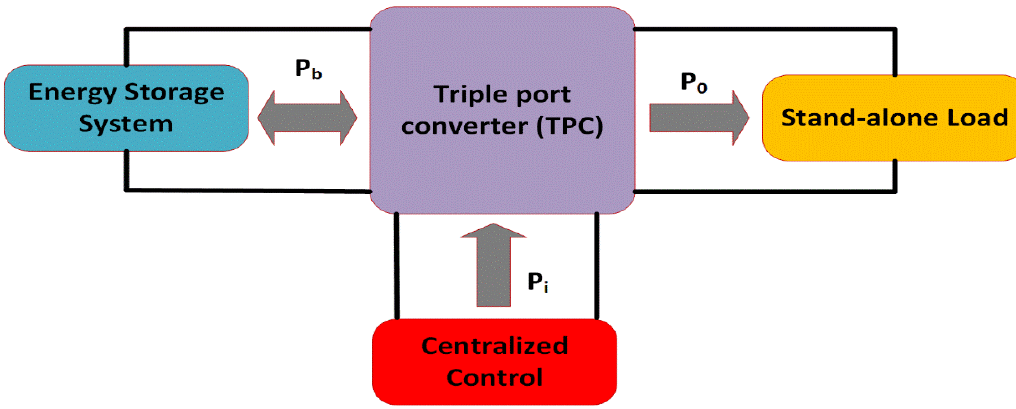
Figure 21. General form of triple port converter.